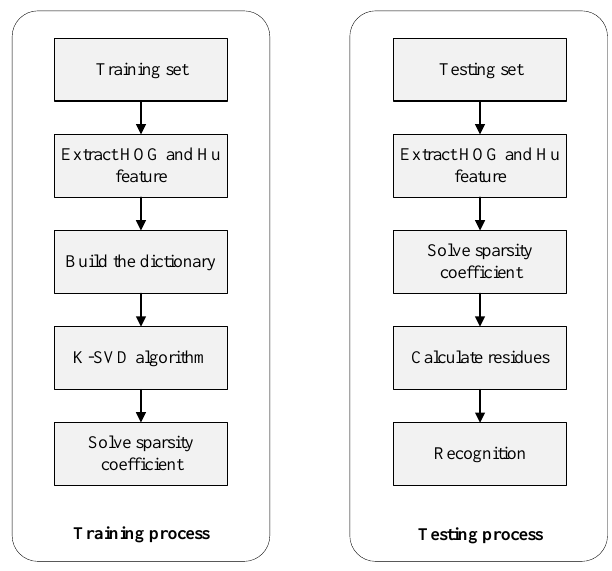
Figure 16. Hand gesture recognition framework.